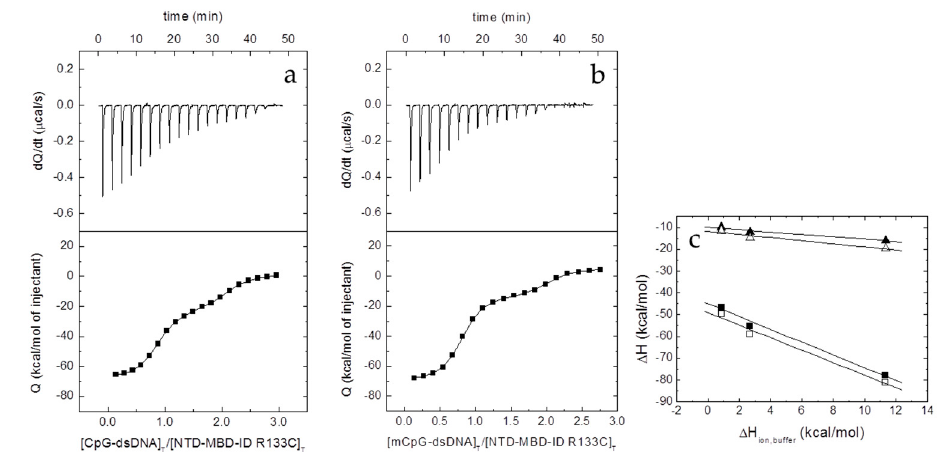
Figure 6. Interaction of the NTD-MBD-ID R133C with unmethylated CpG-dsDNA ( a ) and methylated mCpG-dsDNA ( b ) by ITC in Tris 50 mM, 20 ° C, pH 7. Upper plots show the thermogram (raw thermal power as a function of time) and the lower plots show the binding isotherm (ligand-normalized heat effects as a function of the molar ratio). Non-linear least-squares analysis using a two binding sites model allowed estimating the observed binding affinity and enthalpy (continuous lines). ( c ) Equation (2) was employed for estimating the buffer-independent binding enthalpy for both sites (high affinity, squares; low affinity, triangles) for CpG-dsNA (open symbols) and mCpG-dsDNA (closed symbols). From linear regression, the intercept with the y -axis (observed enthalpy extrapolated at zero buffer ionization enthalpy) provides the buffer-independent interaction enthalpy Δ H , and the slope provides Δ n H .